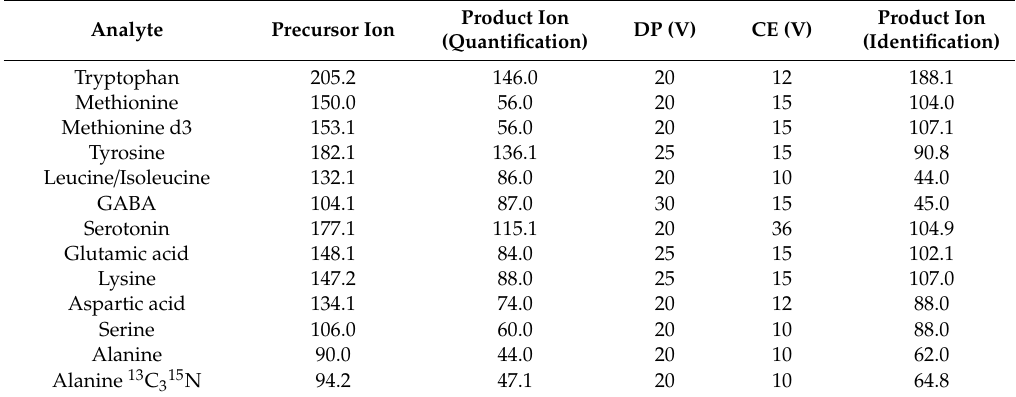
Table 2. MS / MS (SRM) ion transitions, cone energy (DP), and collision energy (CE) for each analyte.